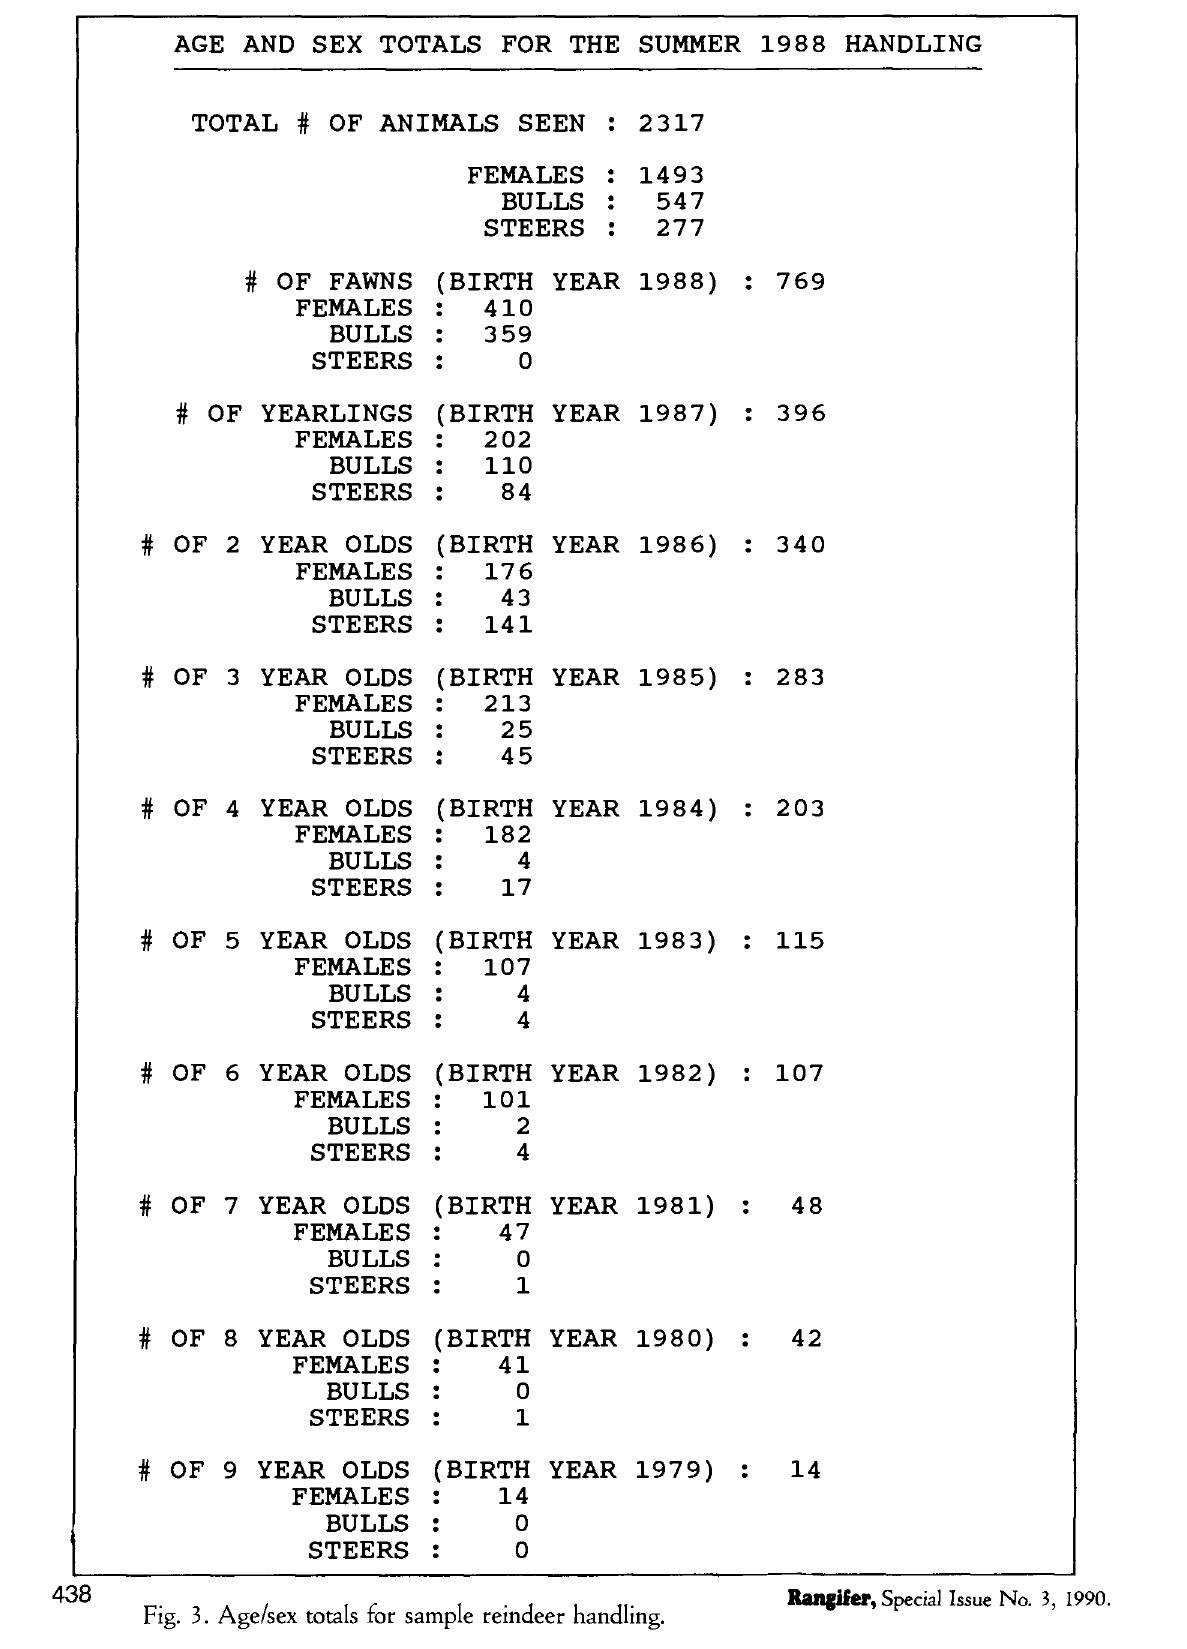
Fig. 3. Age/sex totals for sample reindeer handling.